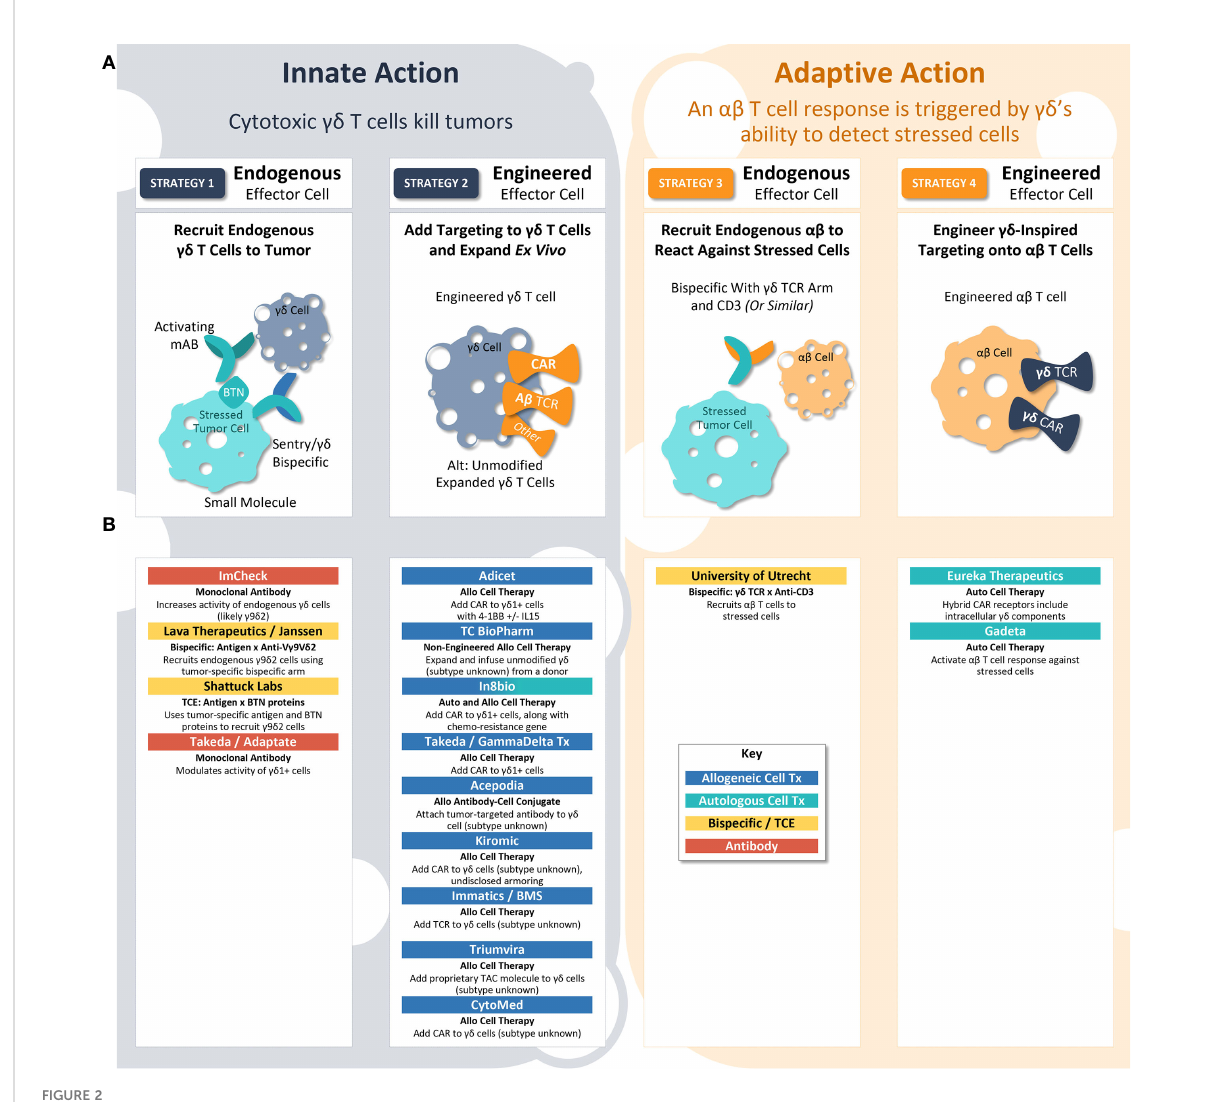
FIGURE 2 gd T Cell-Inspired Clinical Strategies. (A) gd T cell biology may be employed to eliminate tumors by four different strategies. In strategy 1, endogenous gd T cells kill the tumor. In strategy 2, exogenous engineered gd T cell therapies kill the tumor. In strategy 3, gd T cell receptor biology is used to recruit an endogenous ab T cell adaptive response to stressed tumor cells. In strategy 4, gd T cell receptor biology is used as a targeting strategy for traditional ab CAR-T cells to identify and attack stressed tumor cells. In each of these strategies, researchers can either employ validated protein constructs (e.g., CARs using GP3C – 4-1BB – CD3 z from Adicet) or engineer innovative protein structures (e.g., fusion protein chains of CD19 – Fc – BTN3A1/BTN2A1 from Shattuck Labs) to maximize anti-tumor activity. (B) Researchers and companies leading investigation into each clinical